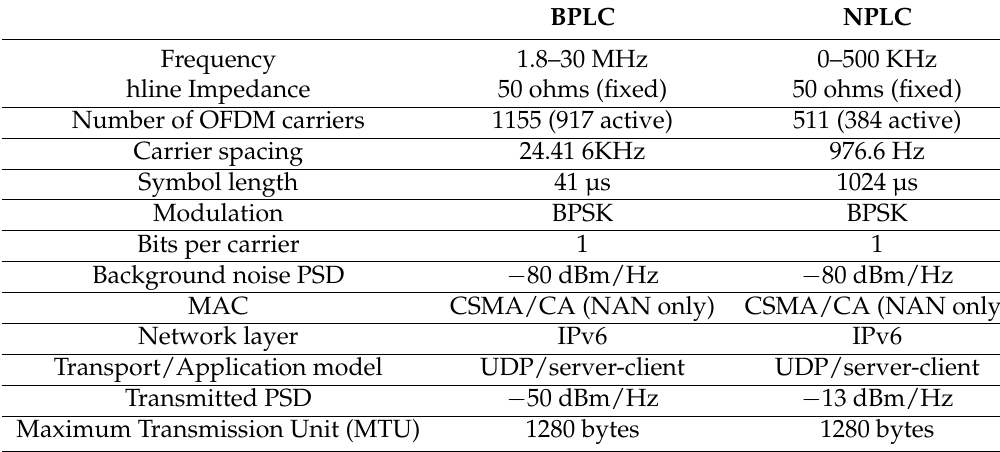
Table 1. power line communications (PLC) Parameters.